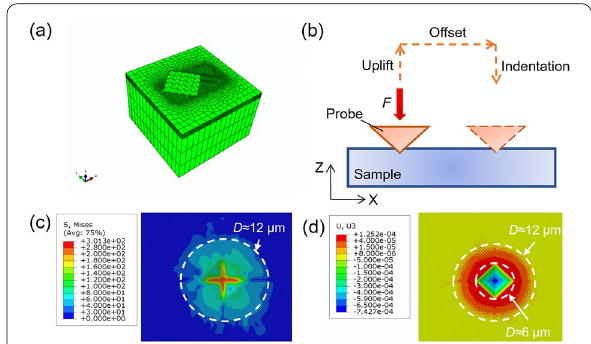
Figure 3 a FE model of the nanoindentation, b Schematic of the indentation process, c Influence region of the residual stress obtained by the nanoindentation with 5 mN, and d The corresponding topography of the